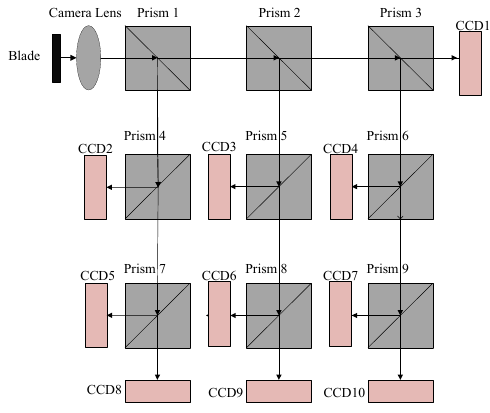
Figure 3. Prisms split the light.